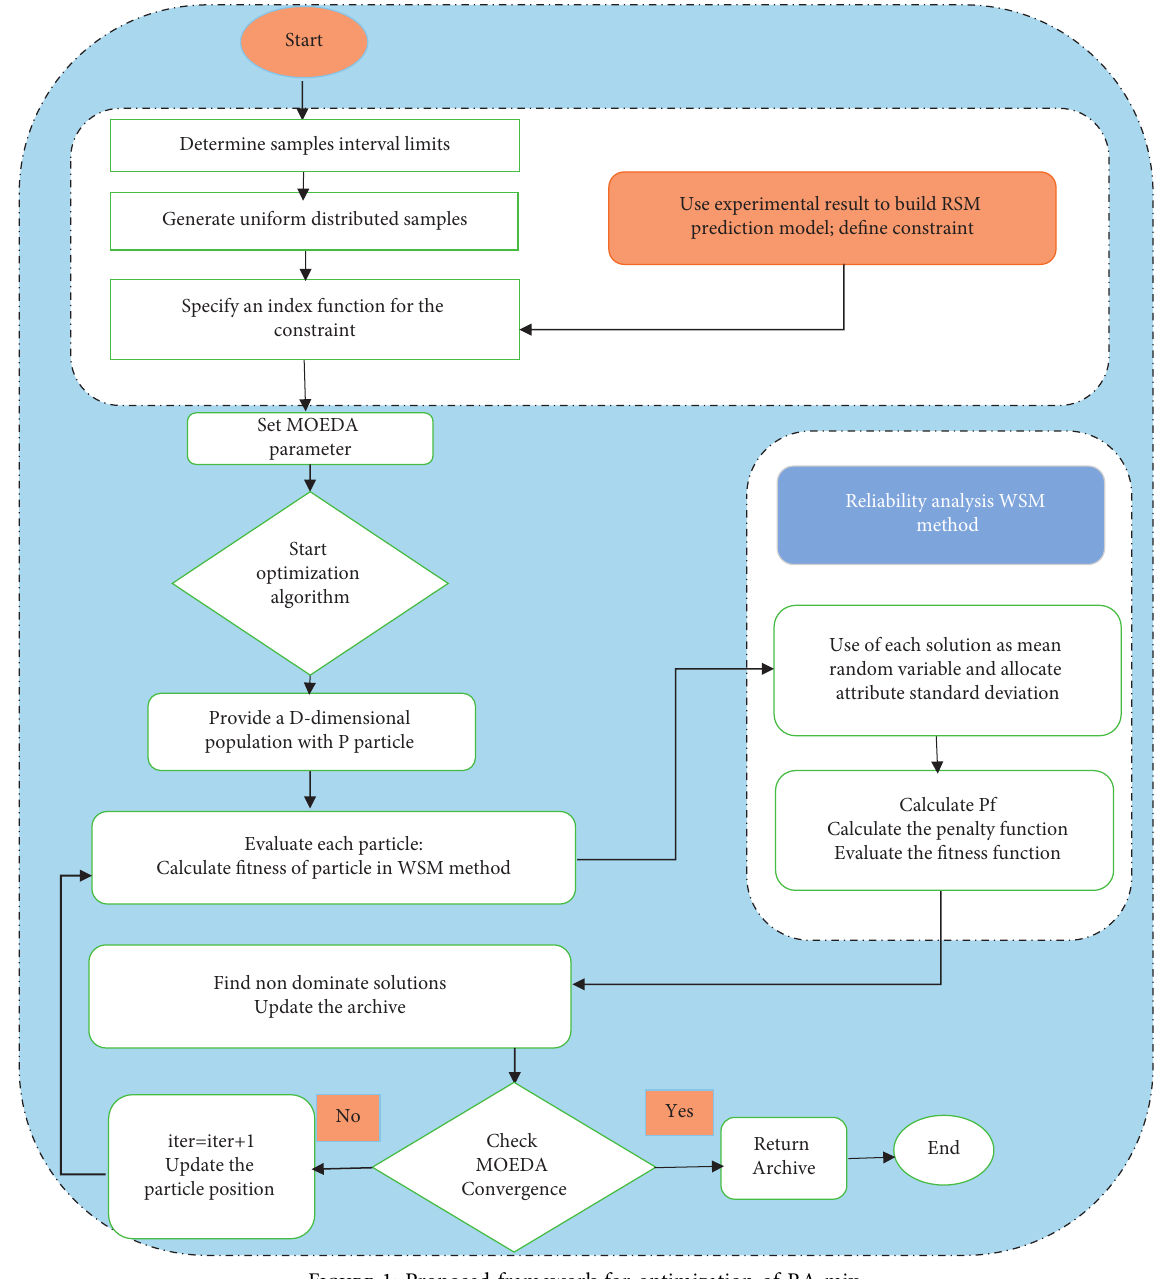
Figure 1: Proposed framework for optimization of RA